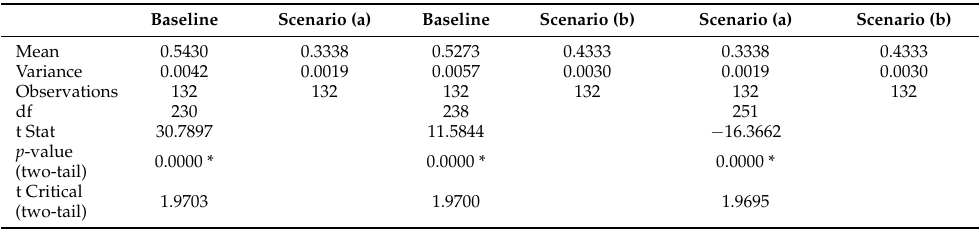
Table 4. The t -test assuming unequal variances of comparisons of the mean of the total relation matrices for the baseline, scenario (a), and scenario